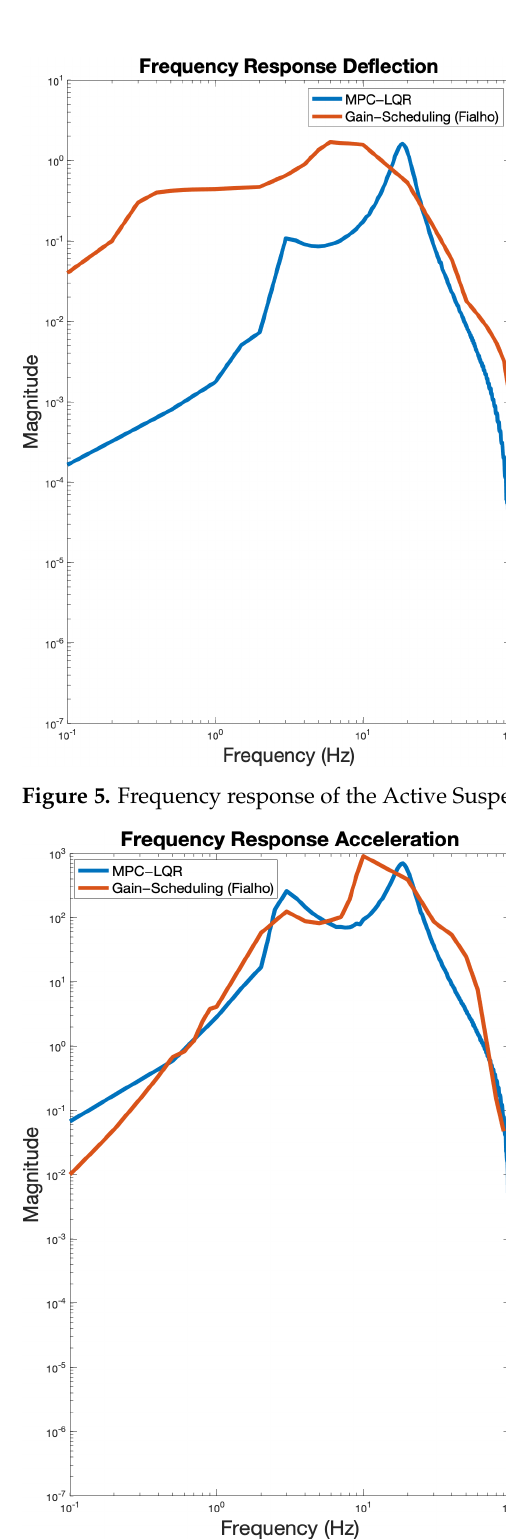
Figure 6. Frequency response of the chassis